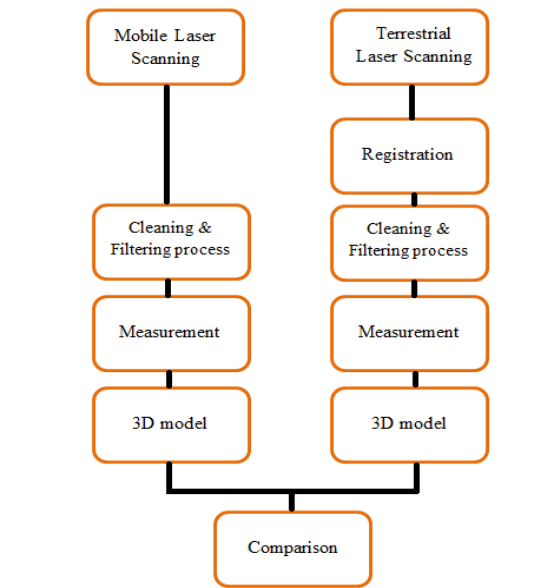
Figure 10. Flowchart for data